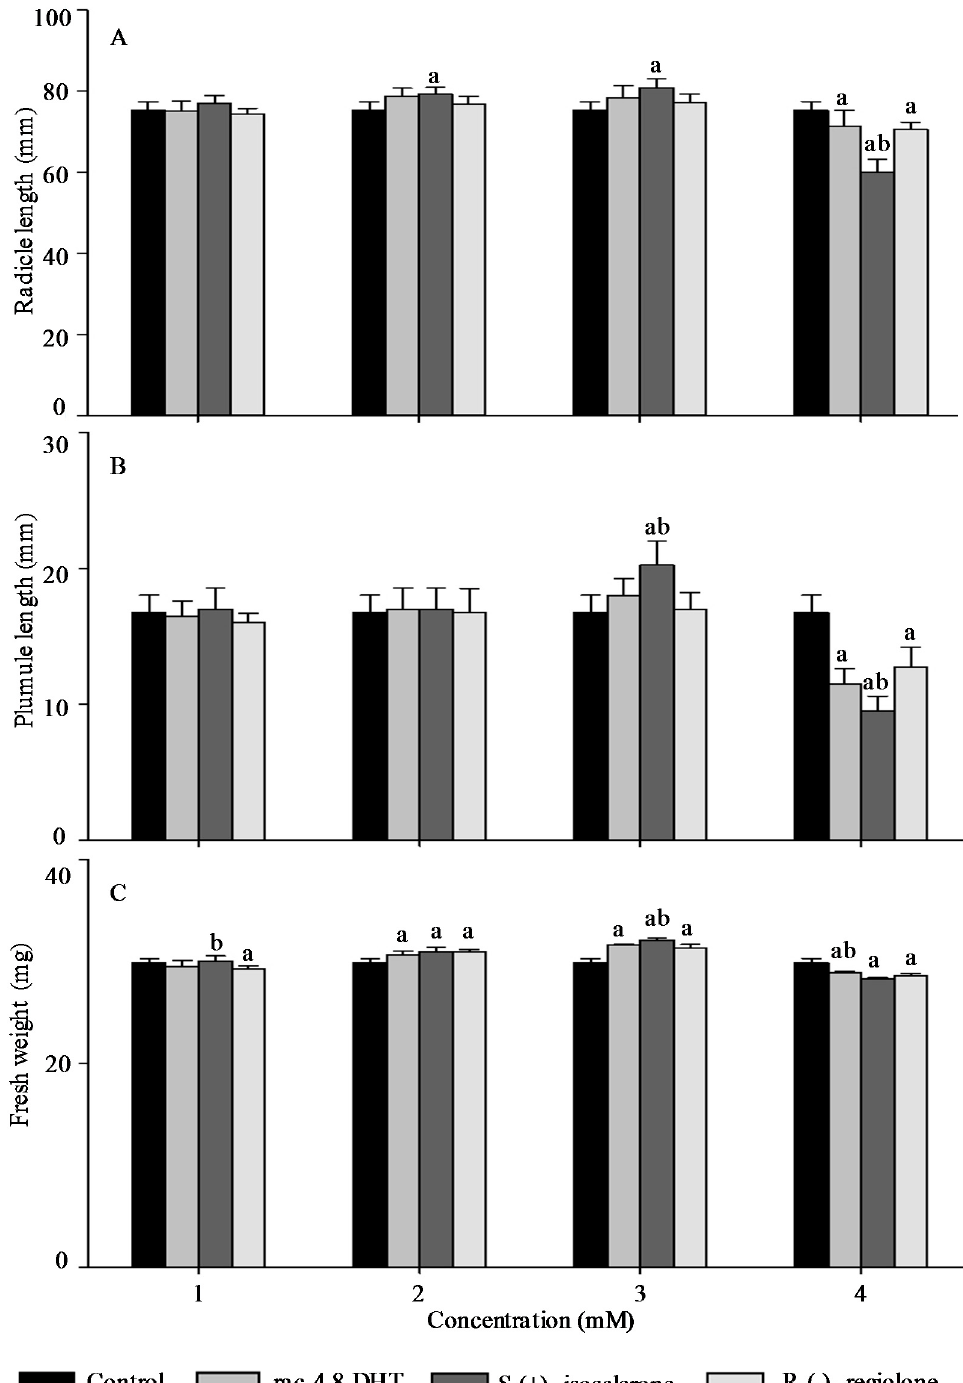
Figure 4. Effect of rac-4,8-DHT, S -(+)-isosclerone, and R -( − )-regiolone at different concentrations on radicle length ( A ); plumule length ( B ); and fresh weight ( C ) in radish. a denotes a significant difference between control and treatments ( p < 0.05); b denotes a significant difference among rac-4,8-DHT, S -(+)-isosclerone and R -( − )-regiolone ( p < 0.05).